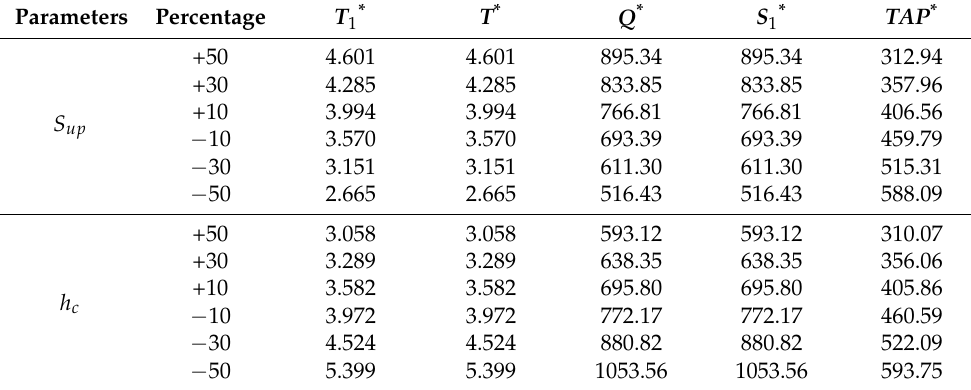
Table 6. Sensitivity analysis on optimum values of the objective function total average profit ( TAP ∗ ), and decision variables, namely.initial inventory level ( S 1 ), lot size ( Q ), active inventory run phase ( T 1 ), total lot cycle ( T ) for the model with shortage with respect to the input variables ( S up , h c , p , s c , c ) varying them from − 50% to +50% of their